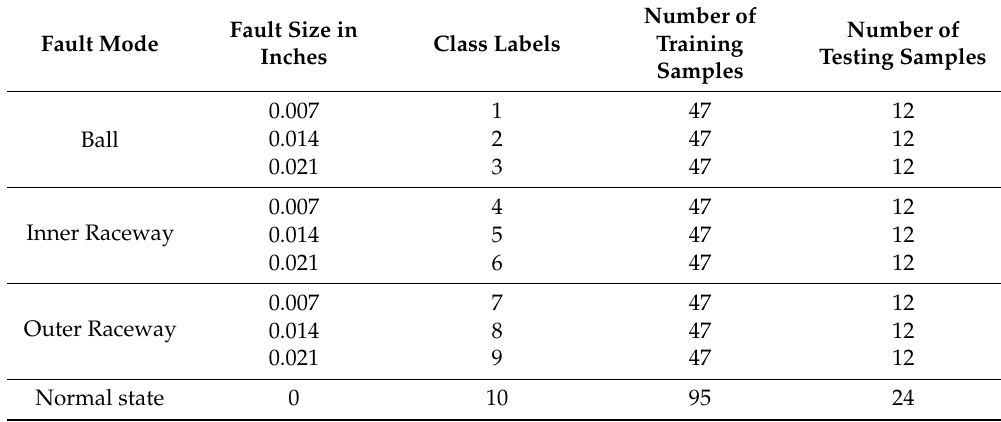
Table 2. Description of the bearing multi-fault conditions and their class labels.